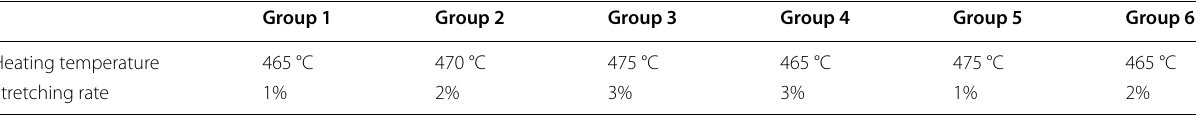
Table 1 Heating temperature and mechanical stretching parameters for residual stress simulation Group